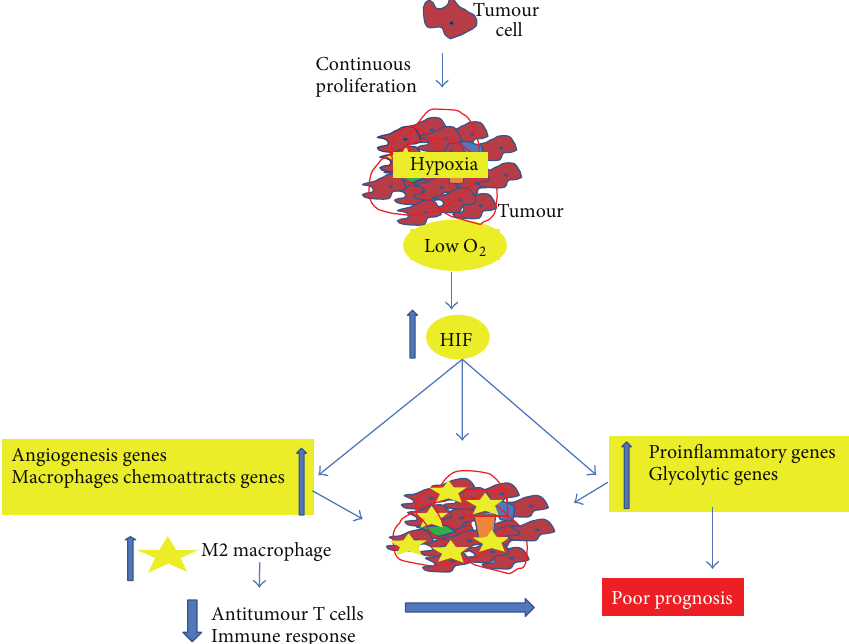
Figure 1: Schematic illustration of the effect of hypoxia on tumour gene expression, macrophage infiltration and antitumour immune